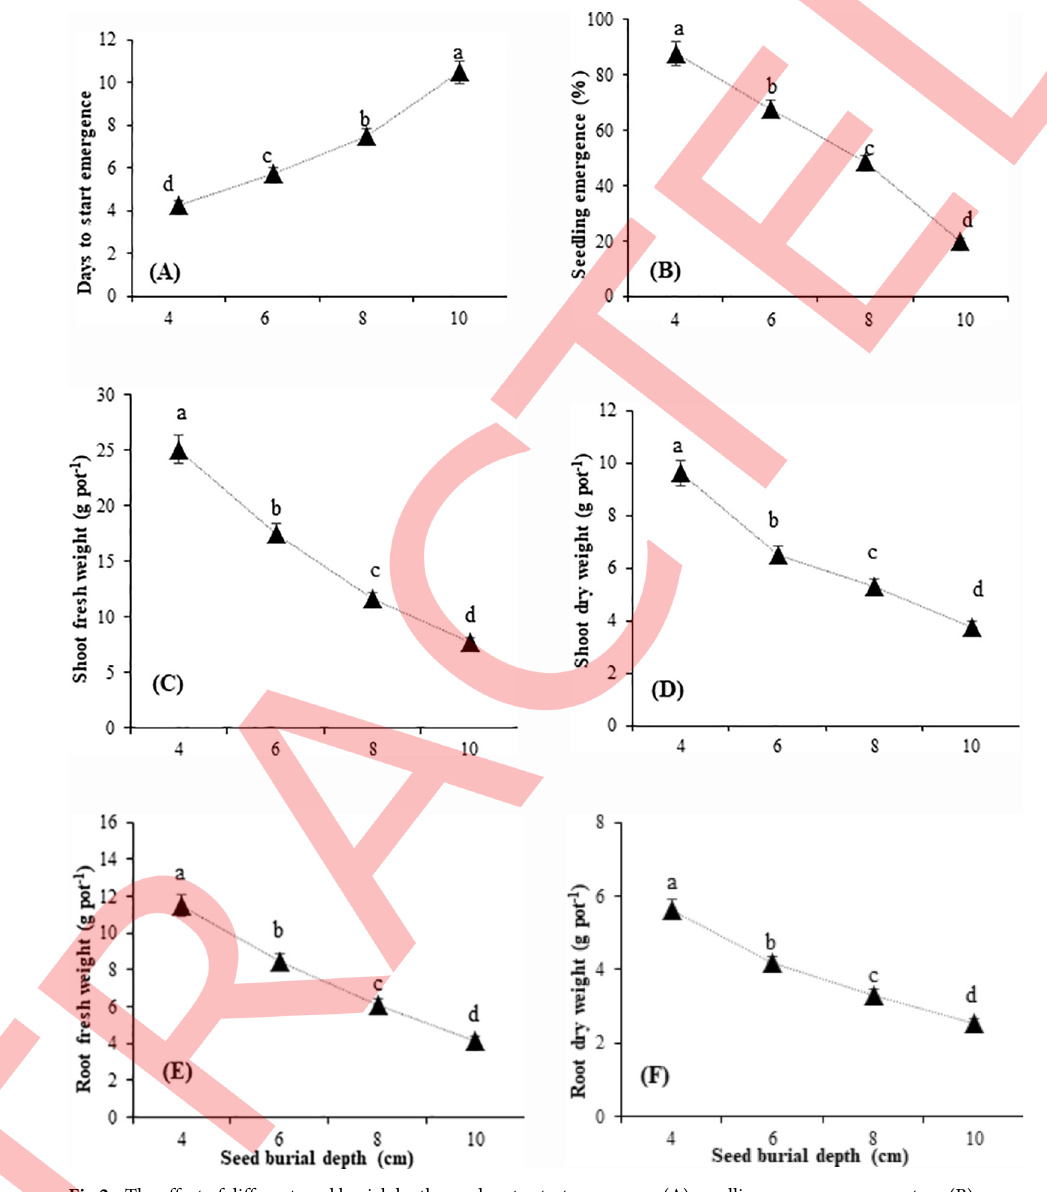
Fig 2. The effect of different seed burial depths on days to start emergence (A), seedling emergence percentage (B), shoot fresh weight (C), shoot dry weight (D), root fresh weight (E) and root dry weight (F) of wild oat.